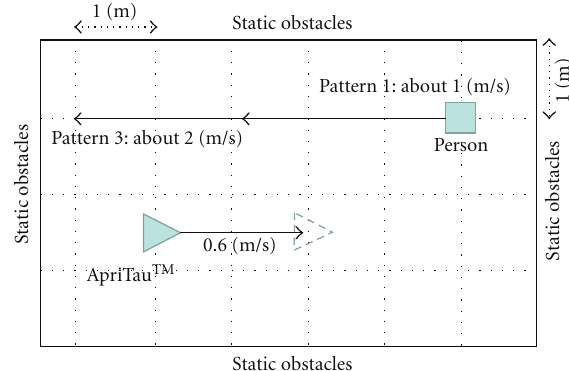
Figure 8: The experimental setting (Pattern 1 and 3).